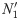
Reasons why the bound of Prop. 2 is not tight.(i) rNNI moves around different arcs may give the same network: the rNNI type-(1) move (u1u2, u1v1, v1v2 → u1v2, u1v1, v1u2) and the rNNI type-(2) move (u1u2, u2v2, v1v2 → u1v2, u2v2, v1u2) on N1 both give the network N1′. (ii) Some of the moves drawn in Fig 8 are not viable rNNI moves: no move of type BR around arc vv4 of N2 is allowed, because of the presence of a v1-v3 path, which would cause the resulting network to contain a cycle. (iii) The bound of Prop. 2 is tight for some networks: the size of the rNNI neighborhood of network N3, equal to 12, coincides with the bound.